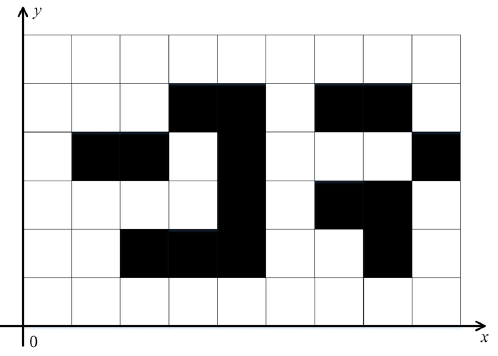
Figure 1. Binary Figure 1. Binary map. F ρ ( th